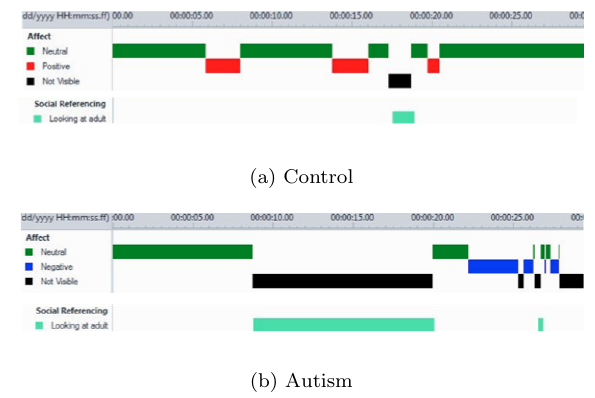
Figure 3: Comparison of sequence of behaviors in a control subject and an autistic subject matched on age during the same stimulus. Green is neutral expression, red is positive expression, dark blue is negative expression, black is not vis- ible, and light green is social referencing (looking at